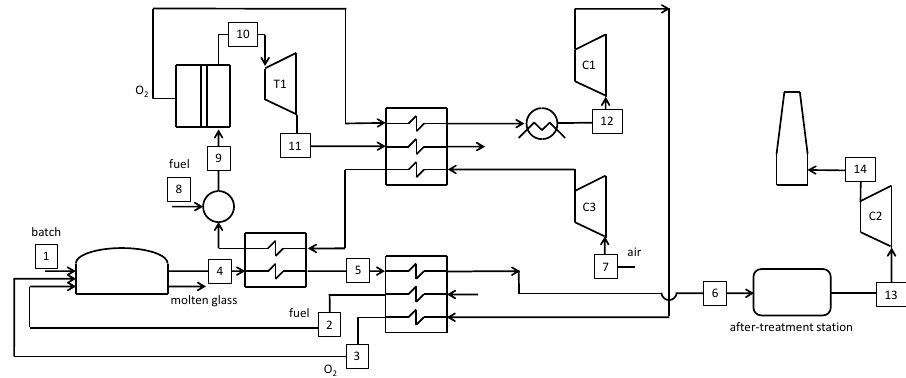
Figure 13. Schematic of the oxy-fuel furnace with integrated 3-end OTM module.